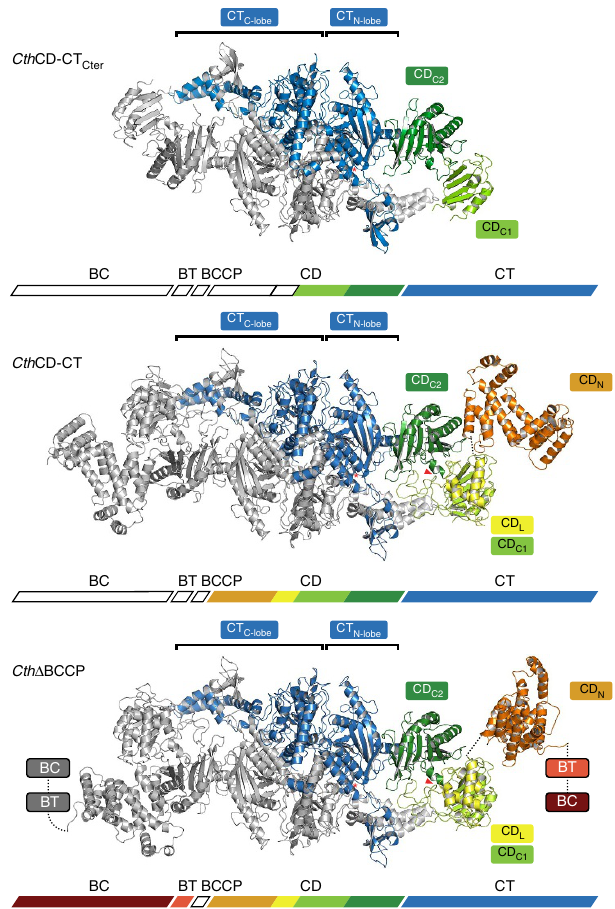
Figure 2 | Architecture of the CD–CT core of fungal ACC. Cartoon representation of crystal structures of multidomain constructs of Cth ACC. One protomer is shown in colour and one in grey. Individual domains are labelled; the active site of CT and the position of the conserved regulatory phosphoserine site based on Sce CD are indicated by an asterisk and a triangle, respectively.